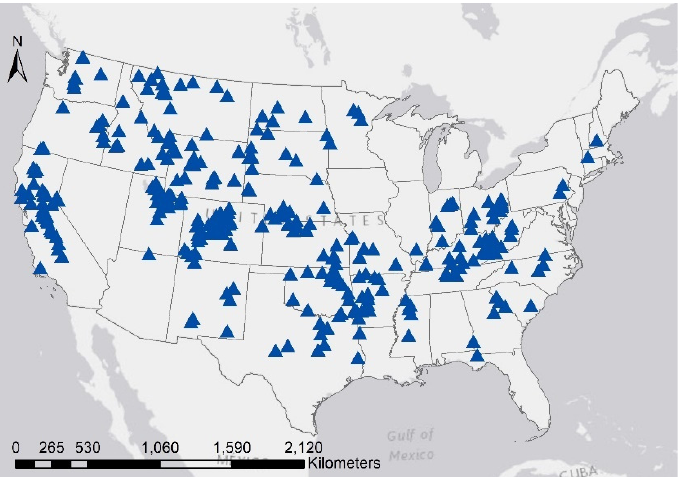
Figure 1. The location of 304 selected U.S. reservoirs.